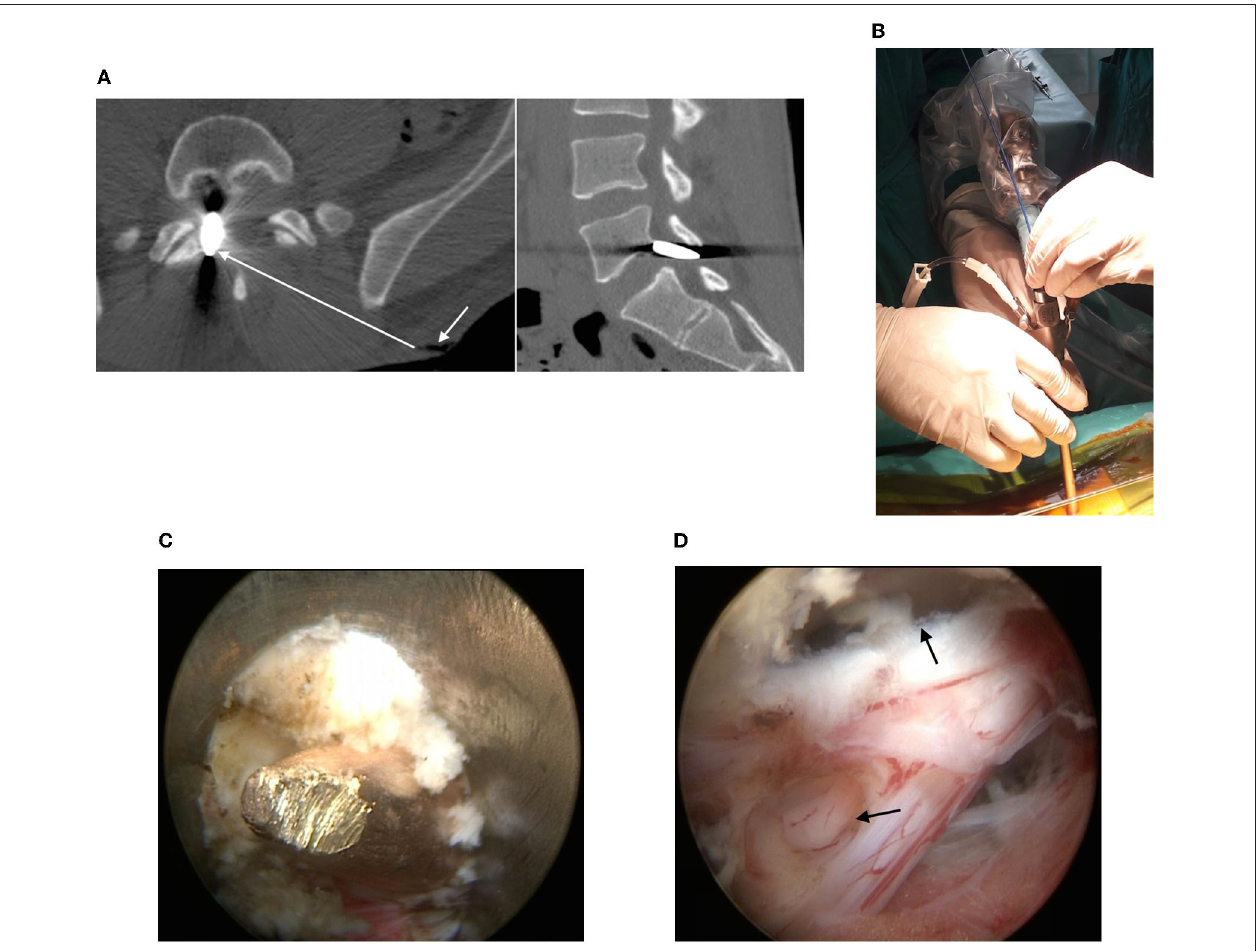
FIGURE 1 | (A) CT scans of the lumbar spine: metallic foreign body (bullet) in the right half of the spinal canal (the arrow shows the inlet of the gunshot wound, the line shows an approximate trajectory of the bullet through the soft tissues); (B) View of the working port and endoscope; (C) Bullet mobilization in a yellow ligament defect; (D) Defects in the dura mater around the nerve root cuff and dural sac (see arrows).